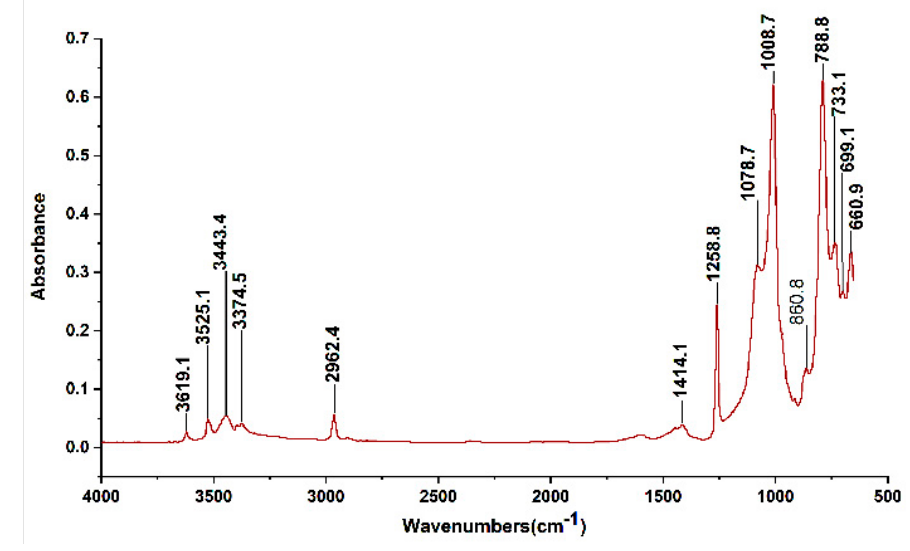
Figure 7. A typical FTIR absorption spectrum.